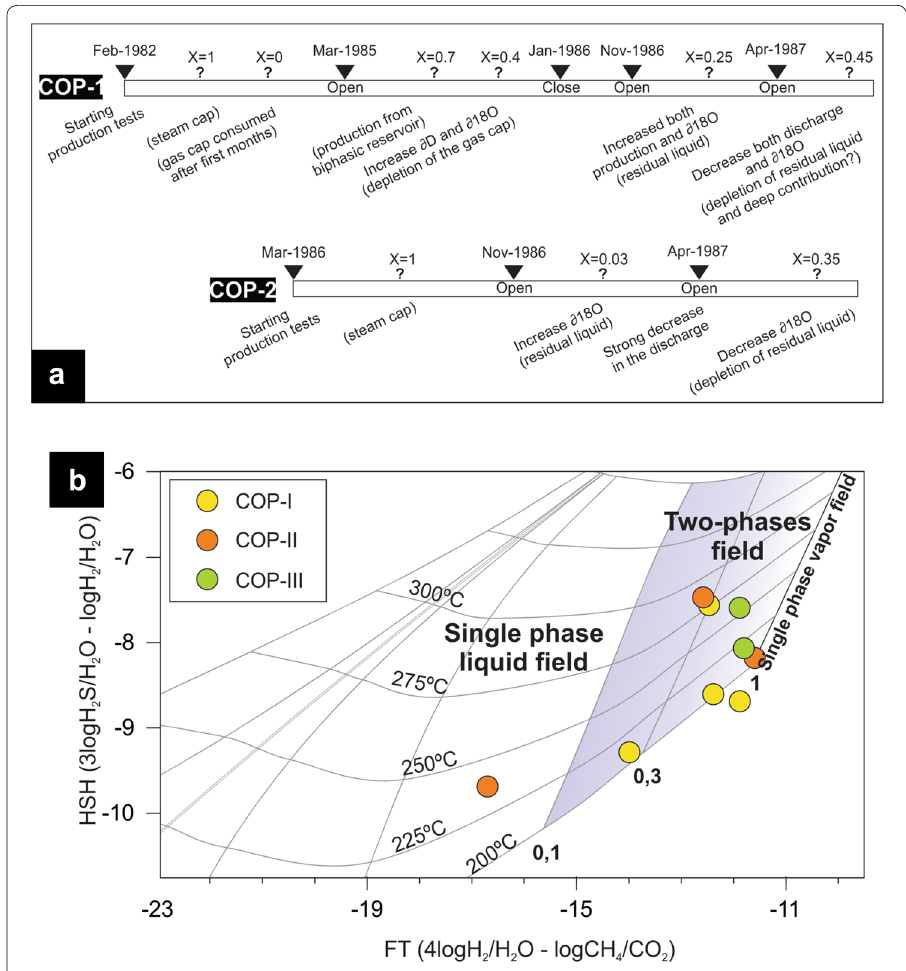
Fig. 9 Available production data from the exploratory wells at Copahue. a Timeline of the production data from Sierra et al. (1992) for two wells. The interpretation based on water isotopes is shown in brackets. X steam molar fraction. b FT-HSH diagram (D’Amore and Truesdell 1985) from fluid discharge during = different stages of production tests that shows a variable vapor–liquid fraction (Panarello